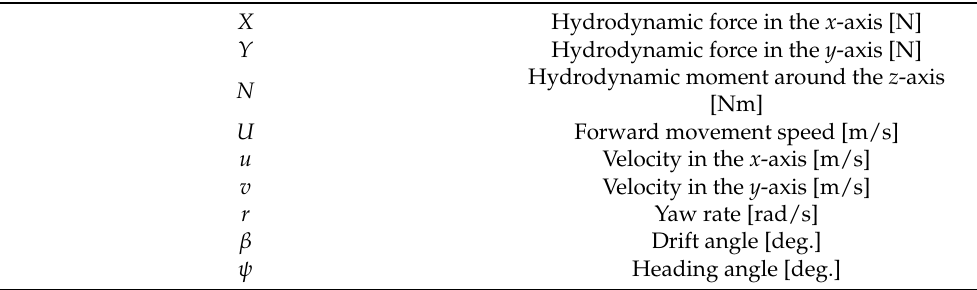
Table 2. Significance of symbols.